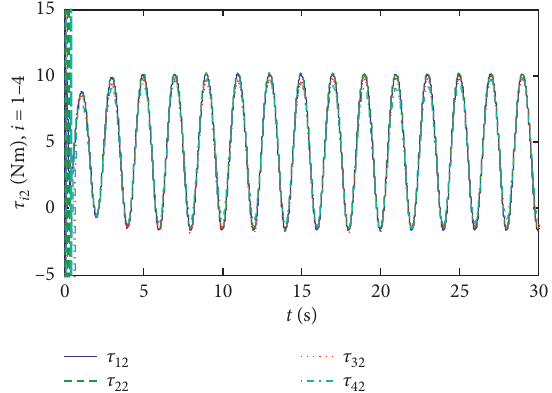
Figure 20: The control input torque τ